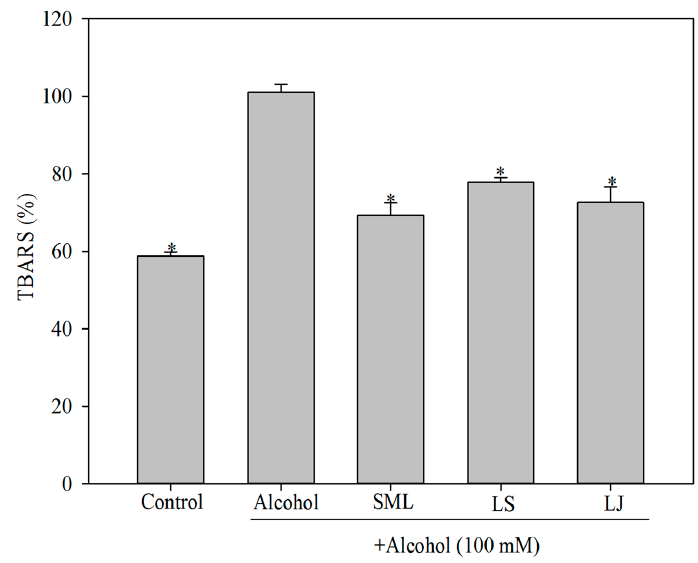
Figure 2. Effects of heat-killed Lactobacillus salivarius (LS), Lactobacillus johnsonii (LJ) and silymarin (SML) on malondialdehyde (MDA) levels in human HepG2 cells induced by alcohol. Experimental conditions were as described in the Materials and Methods. Bars represent mean ± SD ( n ≥ 3). * p < 0.05 for any alcohol treatment groups and control group versus alcohol group.